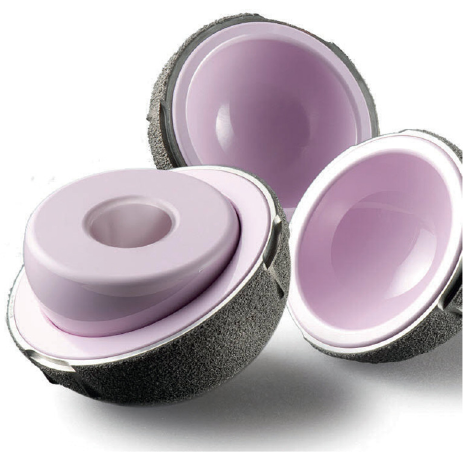
Figure 2. LDH ceramic monobloc acetabular component and ceramic head.